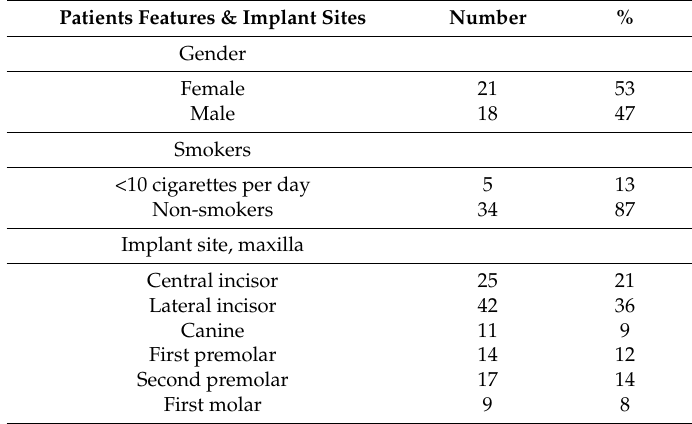
Table 1. Patients, smoking status, and sites, of implants.